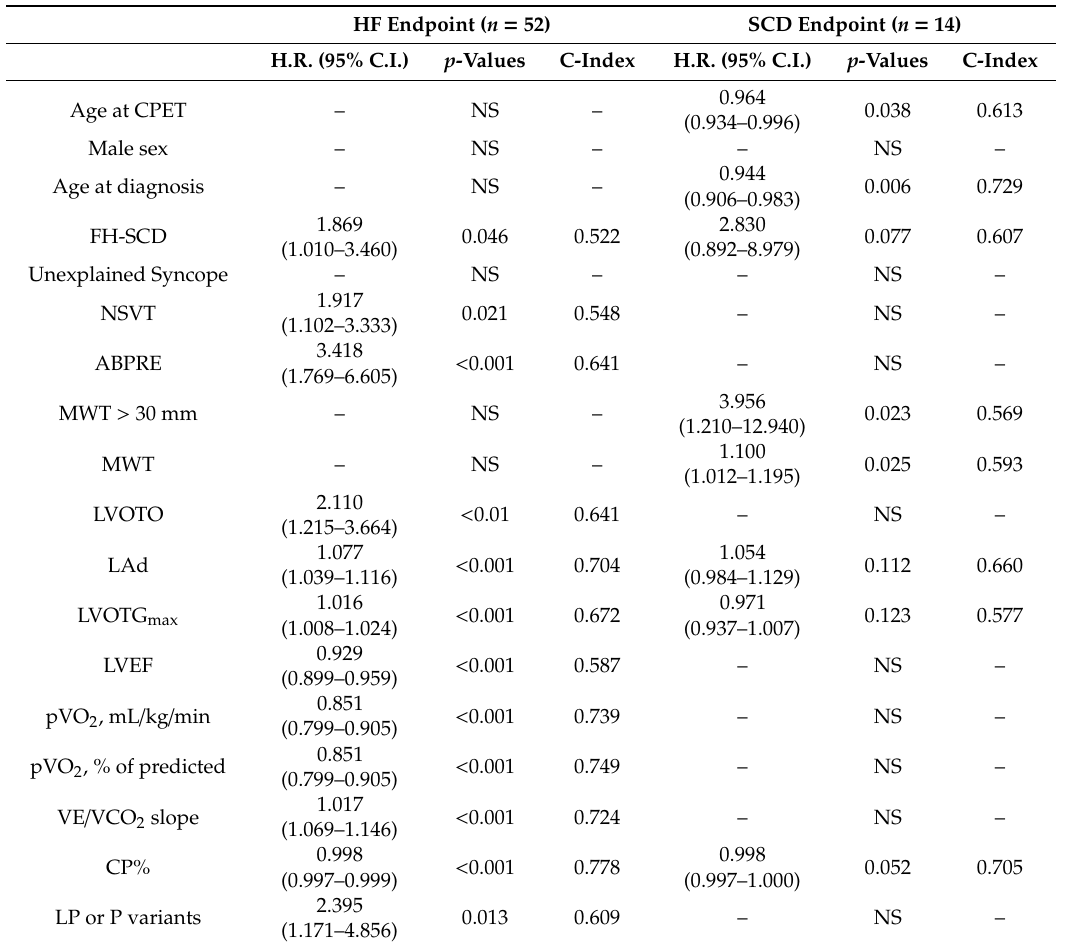
Table 3. Main significant univariate Cox proportional survival analysis according to the clinical variables for the two main study end-points.